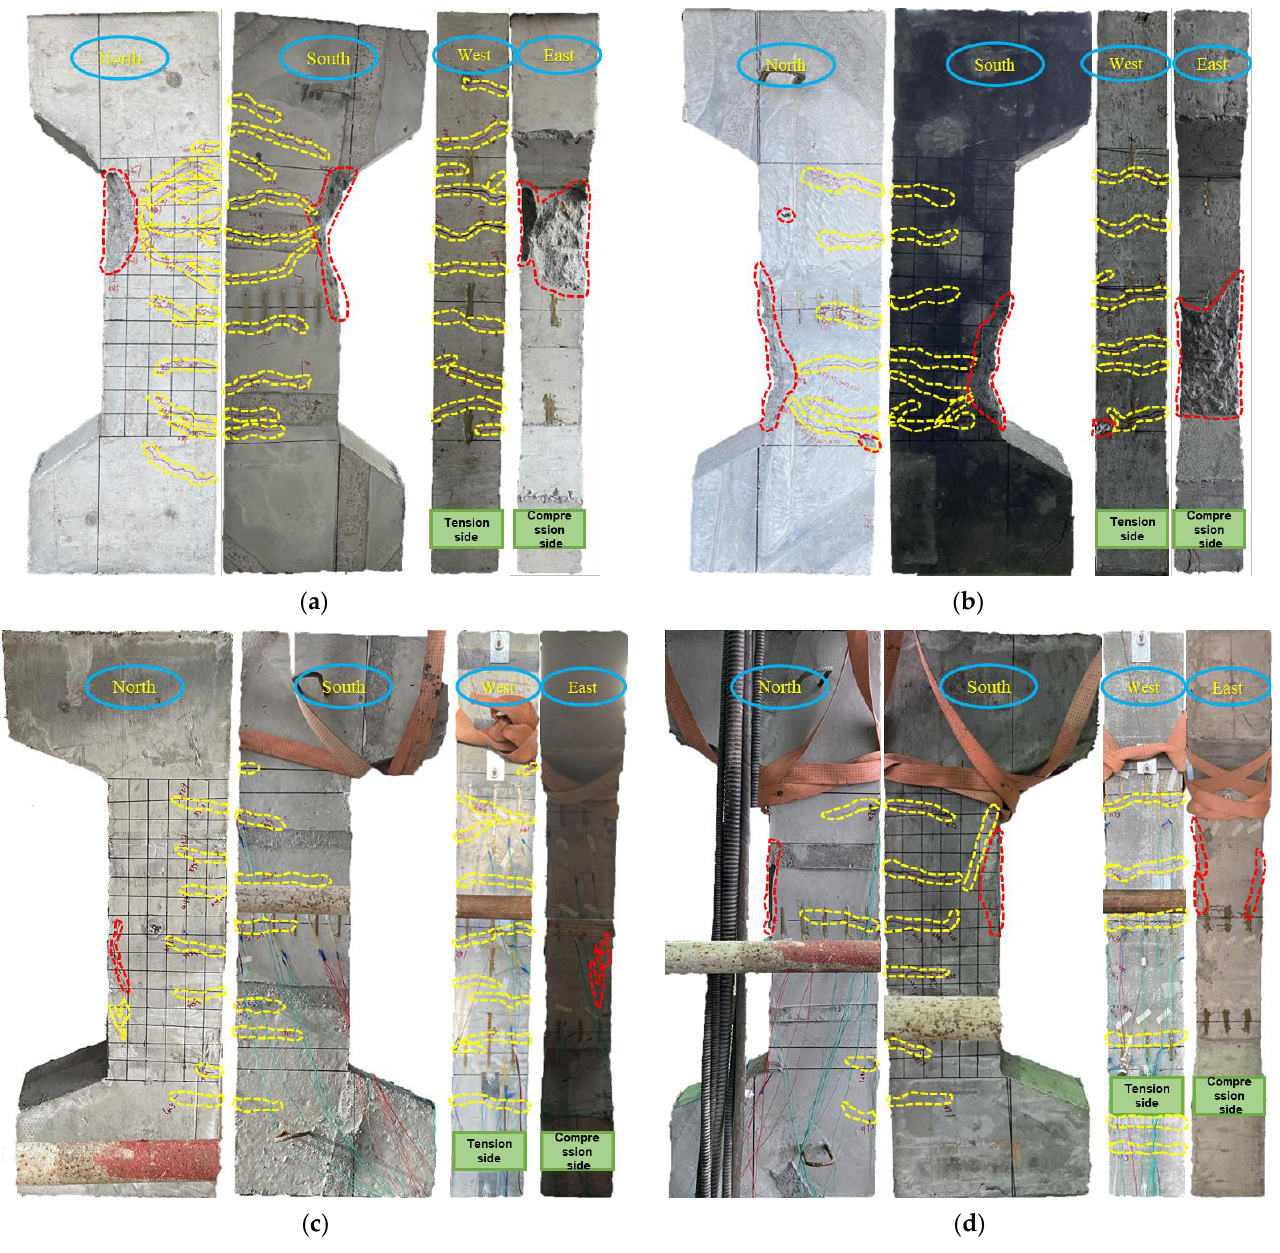
Figure 8. Typical failure modes of RC columns: ( a ) FITRC45-2 column specimen; ( b ) CRC45 column specimen; ( c ) FITRC35-2 column specimen; ( d ) CRC35 column specimen.